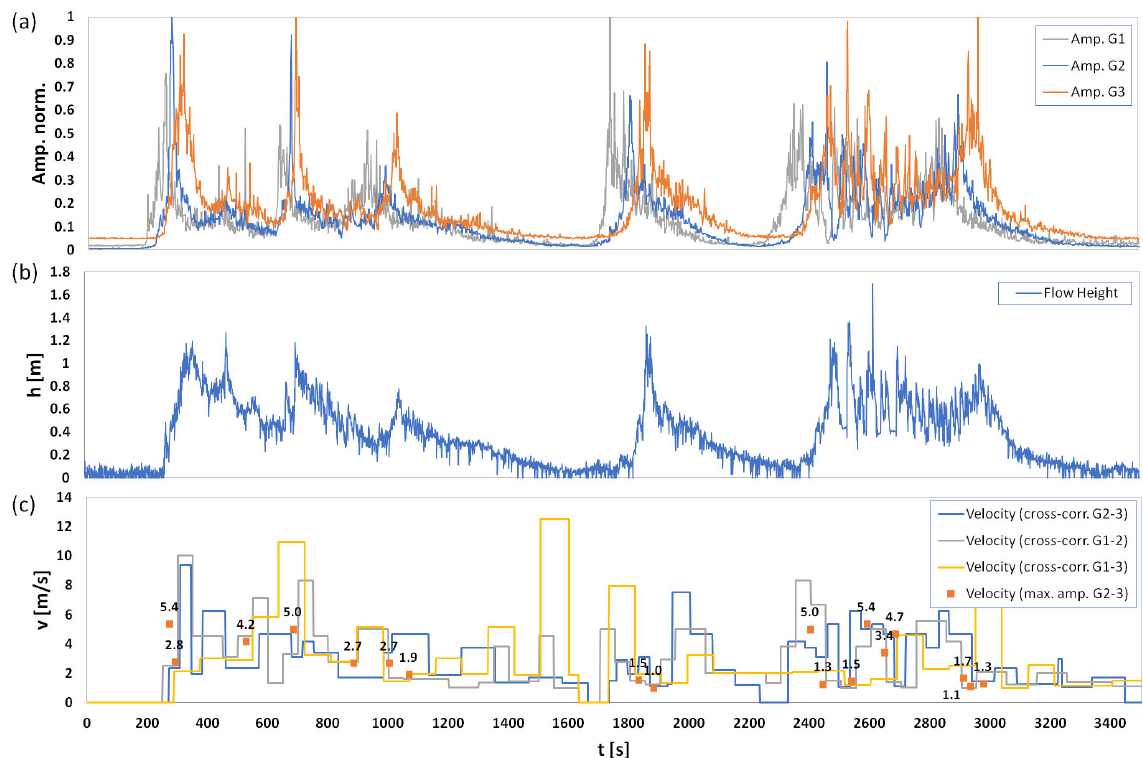
Figure 4. Debris flow at Gadria on 8 June 2015: (a) normalized amplitudes of the three geophones (G1, G2, G3), (b) flow height, and (c) velocity estimation based on maximum values and